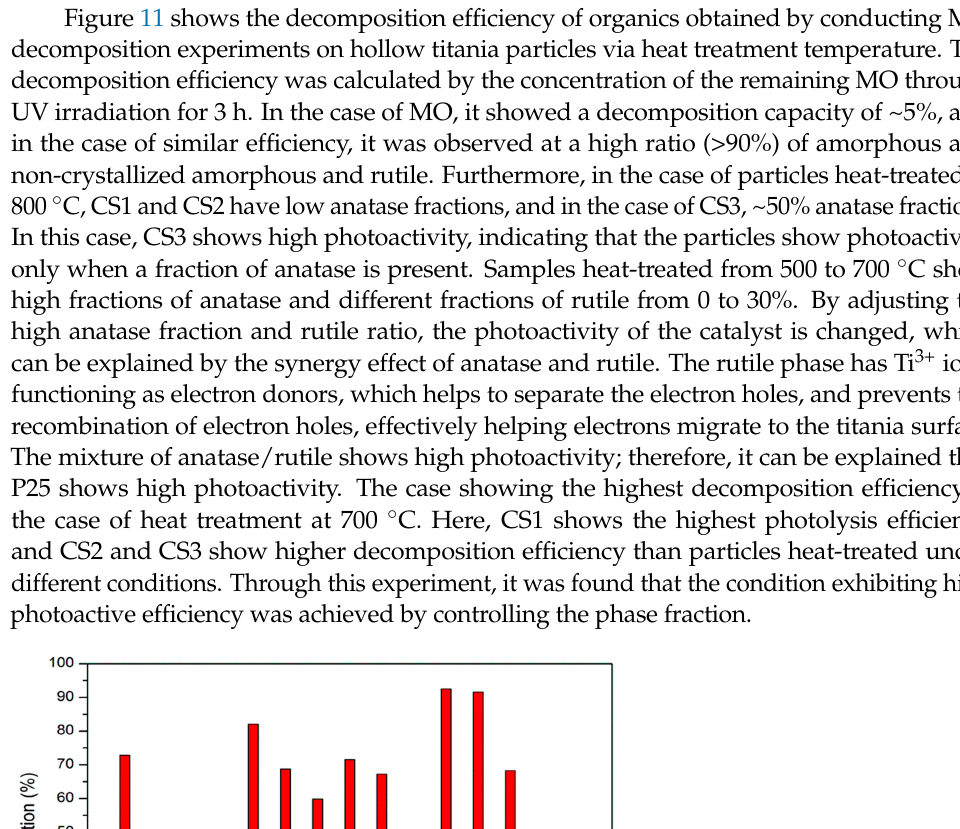
Figure 10. MO decomposition rate of different calcination temperatures ( a ) CS1 and ( b ) CS2.